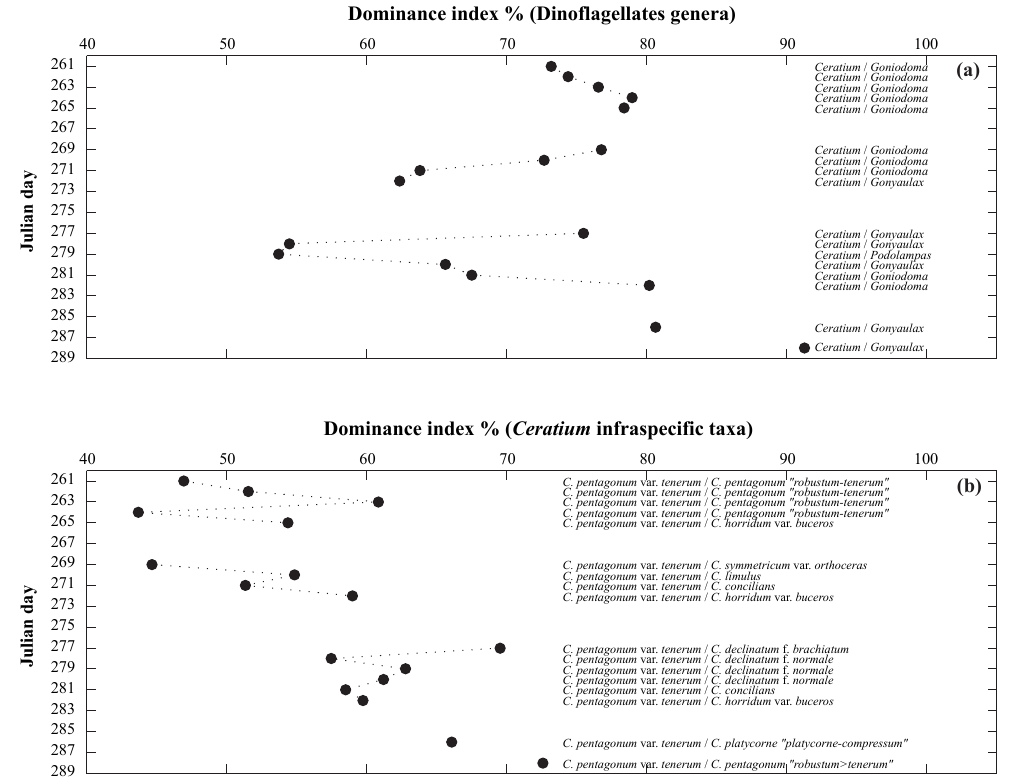
Fig. 5. Evolution of the dominance index in net samples (a) Dinoflagellates genera dominance index, (b) Ceratium taxa dominance